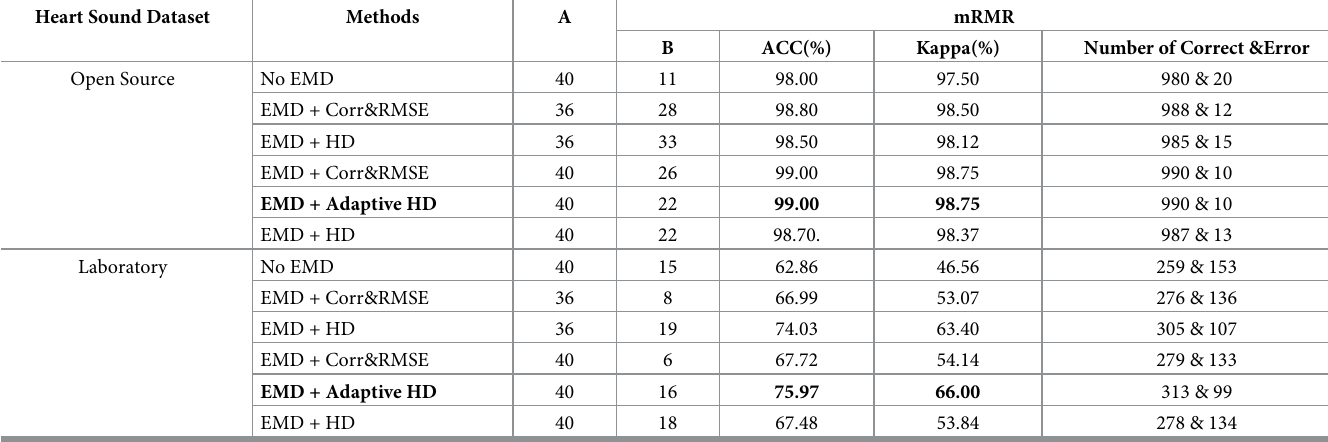
Table 4. Comparison of accuracy and feature dimension under different methods based on mRMR. Heart Sound Dataset